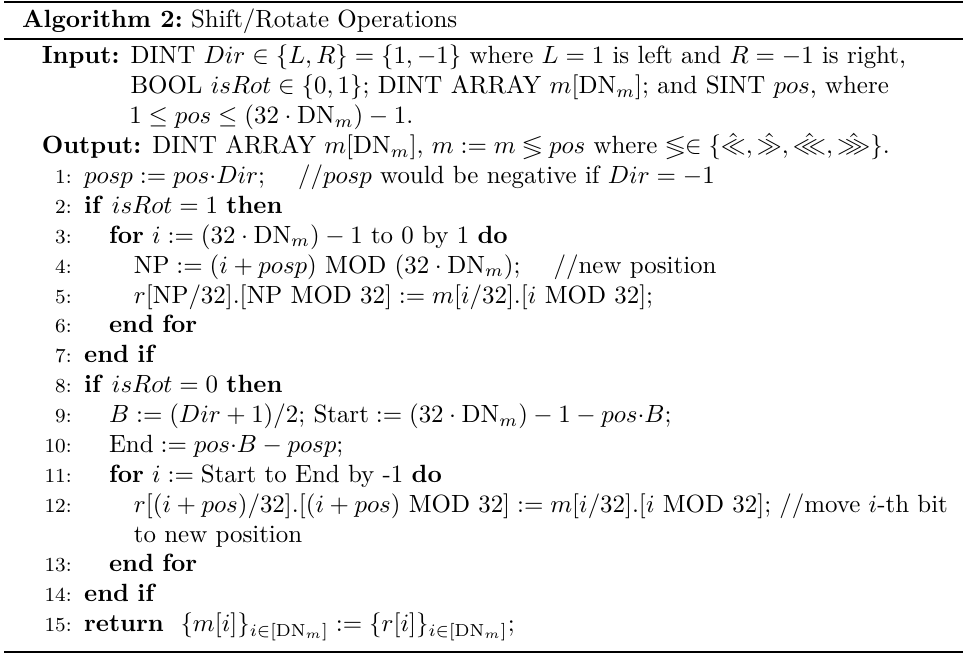
Algorithm 2: Shift/Rotate